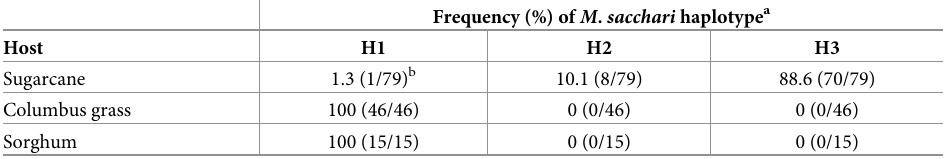
Table 1. Frequency of Melanaphis sacchari haplotypes occurring on three host plants in the Everglades Agricul- tural